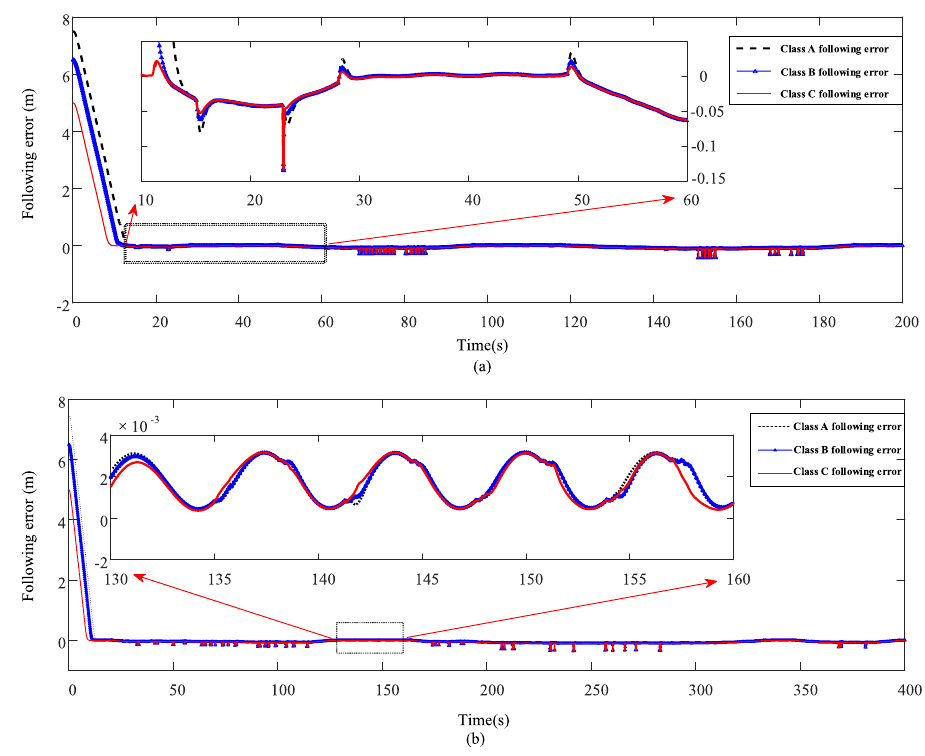
Figure 13. ( a ) Three types of driver following errors corresponding to the standard working condition ECE. ( b ) Three types of driver following errors corresponding to the standard working condition FTP75.